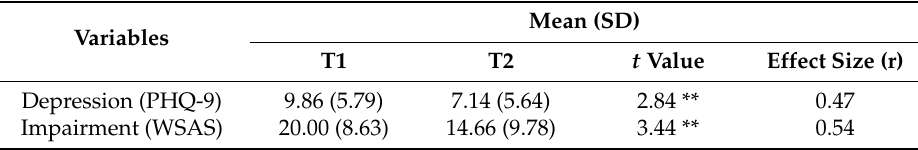
Table 5. Changes in partial completers on select variables ( n =